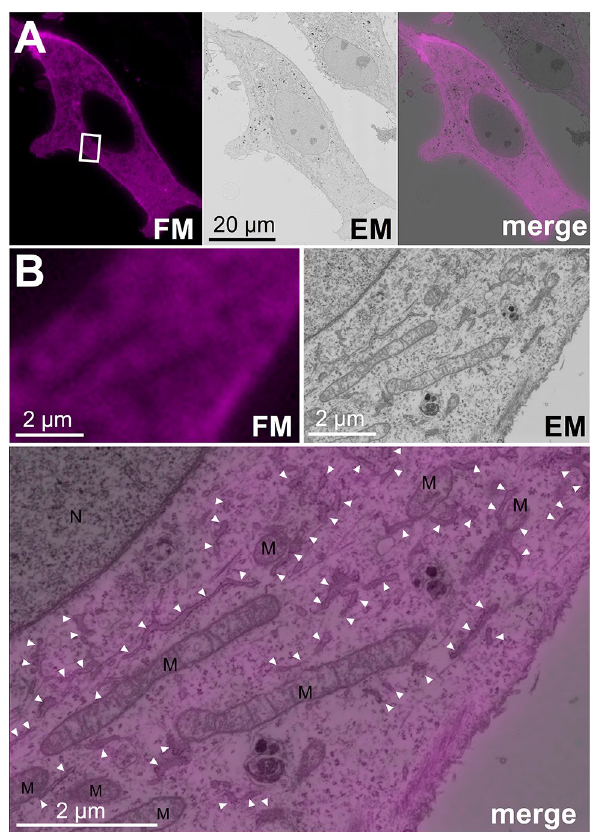
Figure 3. In-resin CLEM of Epon-embedded cells was performed using miniTurbo. Thin sections (100 nm) of Epon-embedded cells expressing miniTurbo (magenta pseudo color) were prepared. Fluorescent images ( FM ) were obtained in the presence of TUK Solution for multicolor using a BZ-X810 fluorescence microscope (CCD monochrome camera, Nikon CFI Plan Apochromat × 100 Oil lens, gain + 16 dB) using a filter set (excitation: 520–570 nm, dichroic mirror: 565 nm long pass, emission: 535–675 nm) for red fluorescent probes. Electron microscopic images ( EM ) were obtained with a Helios NanoLab 660 scanning electron microscope (a backscattered electron detector at a voltage of 2.0 kV and a current of 0.4 nA). The “ merge ” is the merged image of the fluorescence ( FM ) and electron microscopic images ( EM ). The images in ( B ) indicate 10x ( FM and EM ) and × 20 ( merge ) magnification of the respective images corresponding to the boxed area in the merge image in ( A ). M, mitochondria; N, nucleus; arrowheads, endoplasmic